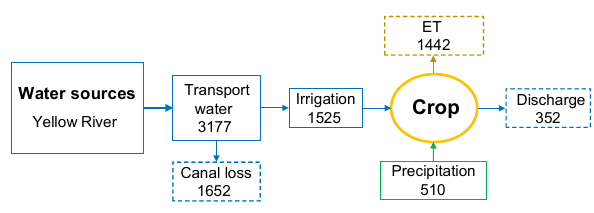
Figure 5. The amount of water during crop growth ( × 10 6 m 3